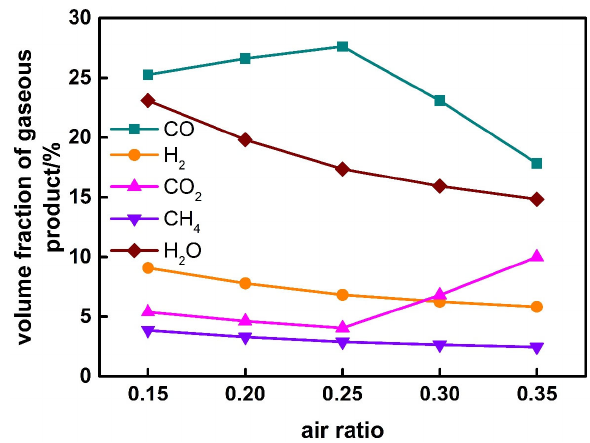
Figure 9. Effect of air ratio on gaseous product.